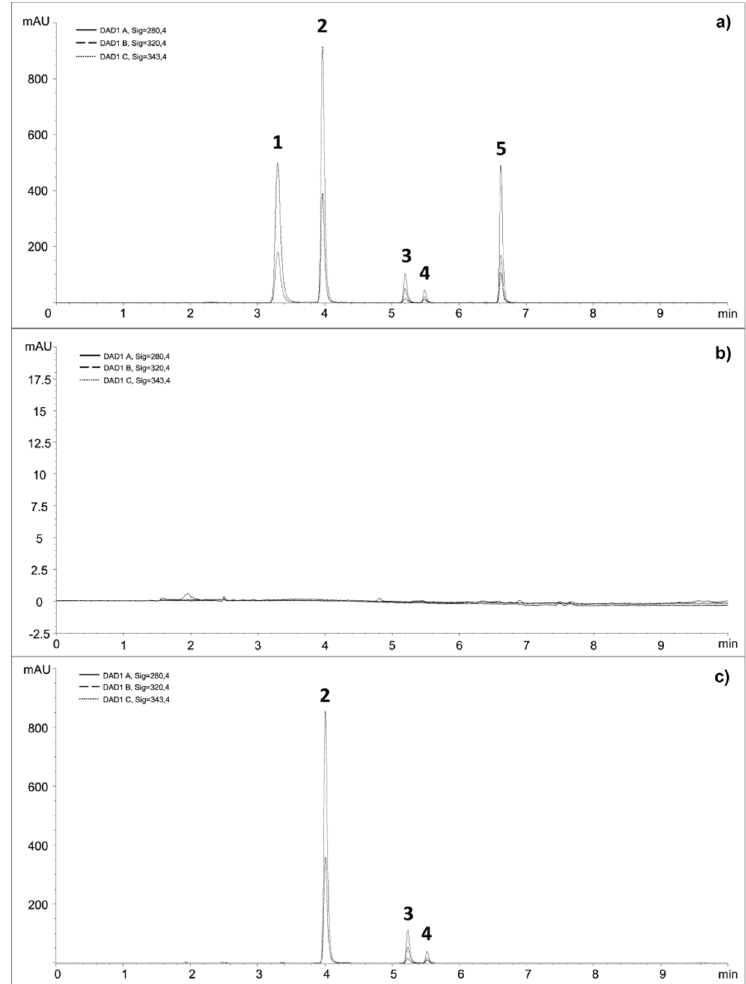
Figure 2. Chromatograms of: ( a ) mixed standard solution of 6-thioguanine (1), 6-mercaptopurine (2), internal standard (3), folic acid (4) and azathioprine (5); ( b ) 0.02 M NaOH solution containing (50 mg/L) (2) and folic acid (5 mg/L) (4) with the addition of internal standard (3). Table 3. System suitability data.